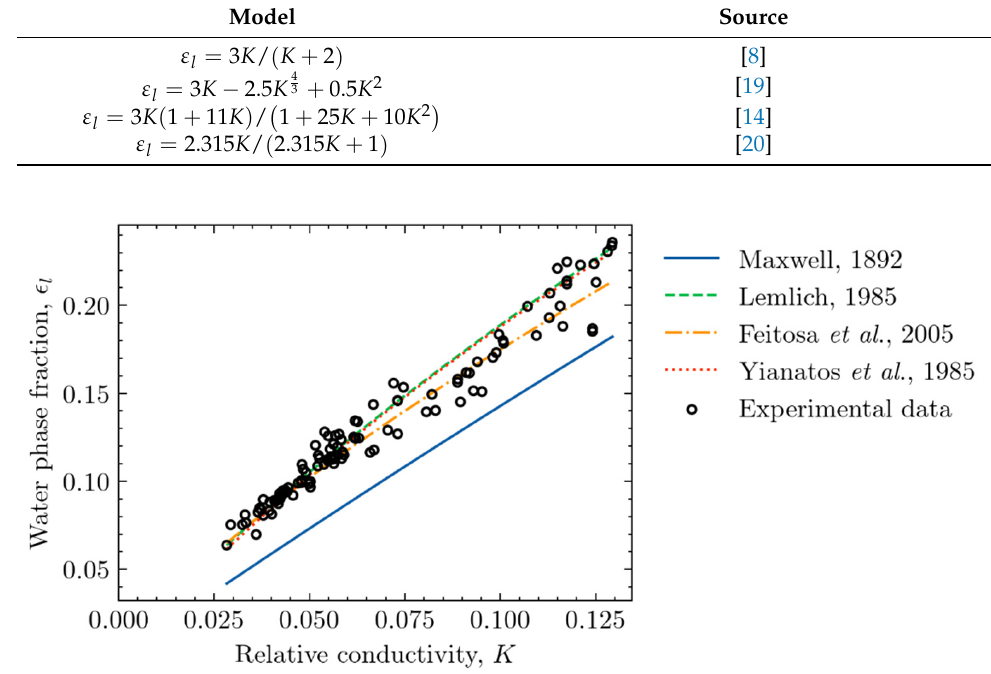
Figure 6. Relationship of froth zone water content and relative conductivity for various models from literature